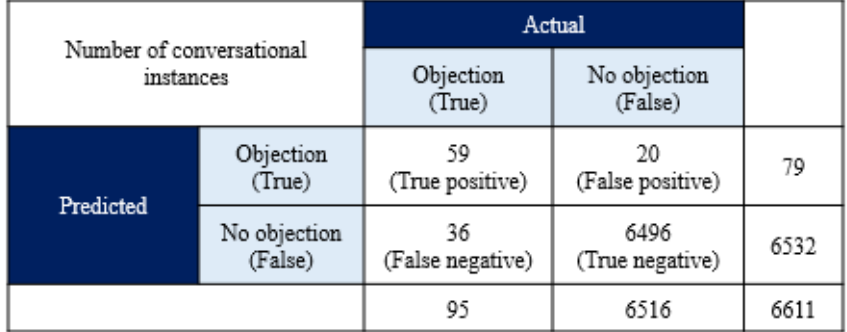
Figure 5. Confusion matrix of the objection handling machine learning